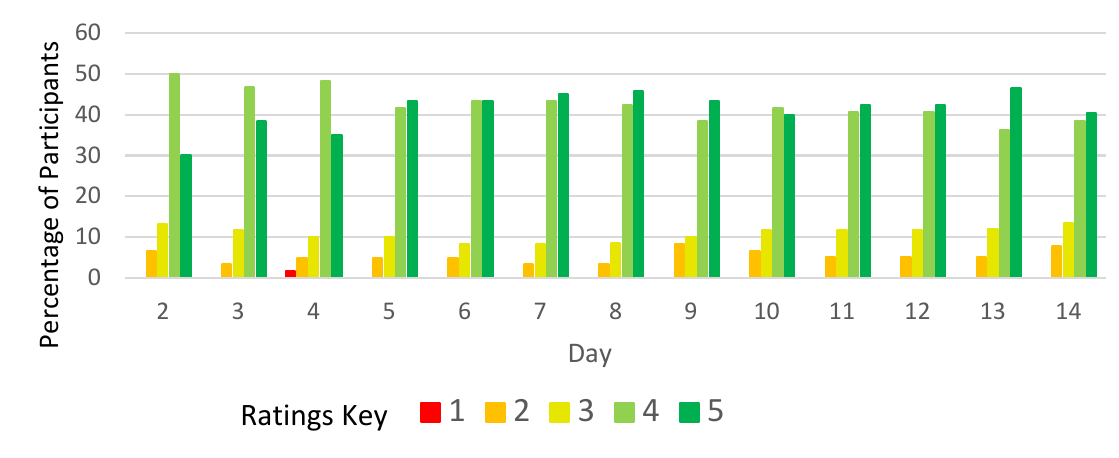
Scheme 13. Parent survey results for: Cleaning.